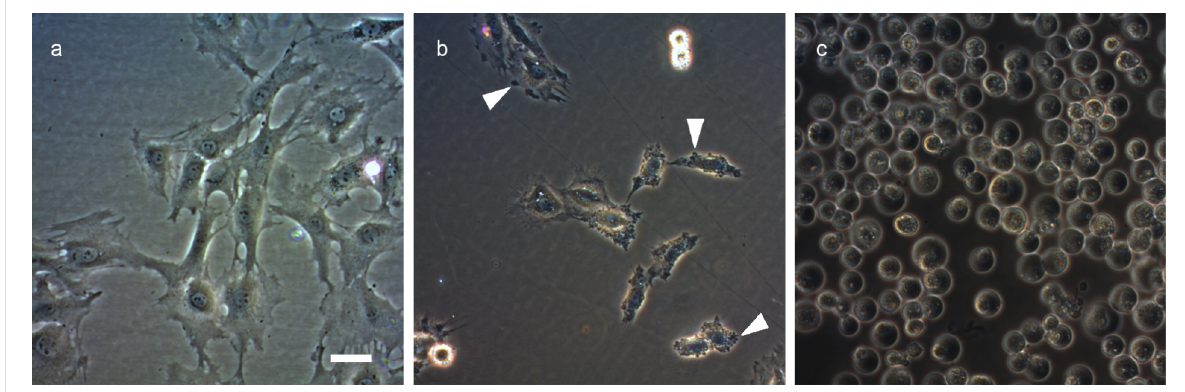
Figure 3: The effect of sacrolide A ( 1 ) on 3Y1 rat fibroblastic cells. (a) Control. (b) 45 min after exposure to 13 μ M of 1 . (c) 20 h after exposure to 13 μ M of 1 . Arrowheads indicate blebs on the cell surface. The magnification is identical in (a), (b) and (c), the bar represents 100 μ m.